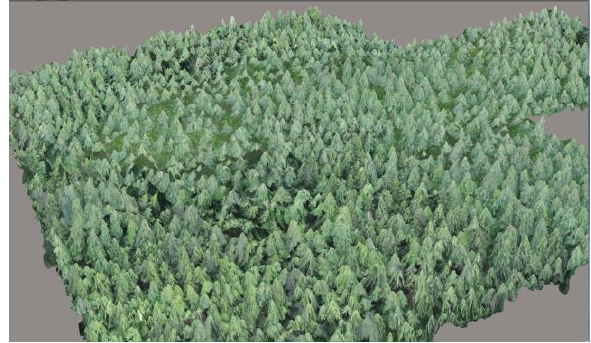
Figure 3. 3D TIN model of the area.